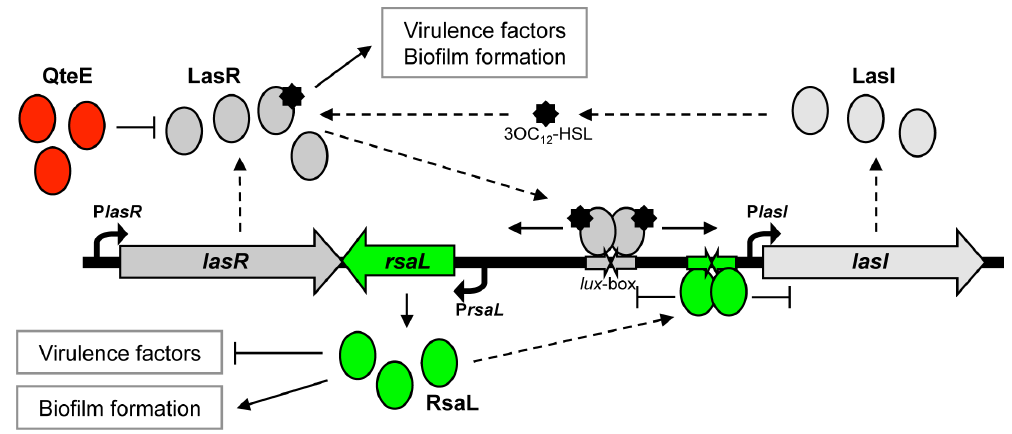
Figure 1. Schematic representation of QteE- and RsaL-dependent regulation of the P.aeruginosalas QS system. In the pre-quorum period, QteE binds to the LasR receptor and prevents the binding of the LasR-3OC 12 -HSL complex to the rsaL - lasI bidirectional promoter [20], hence delaying the onset of the QS response. Once the quorum has been reached, the LasR/3OC 12 -HSL complex triggers the transcription of both rsaL and lasI genes. The consequent increase of 3OC 12 -HSL levels, and thus of activated LasR, generates a positive feedback loop also responsible for the increase of RsaL levels. RsaL binding to the rsaL - lasI bidirectional promoter represses the expression of both rsaL and lasI genes, thus counteracting the positive feedback loop. This circuit provides 3OC 12 -HSL homeostasis [24]. Solid arrows represent positive control; T-shaped lines represent negative control; dashed arrows indicate information flow; curved arrows represent the transcription start points of the indicated genes.